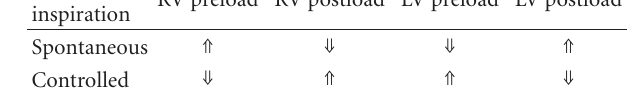
relationships indicated in Table 1. With positive